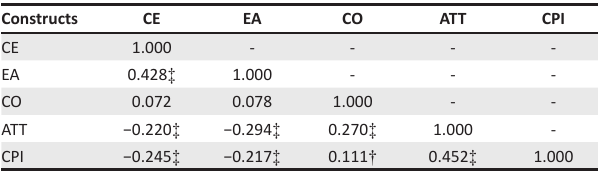
TABLE 3: Structural model comparison.